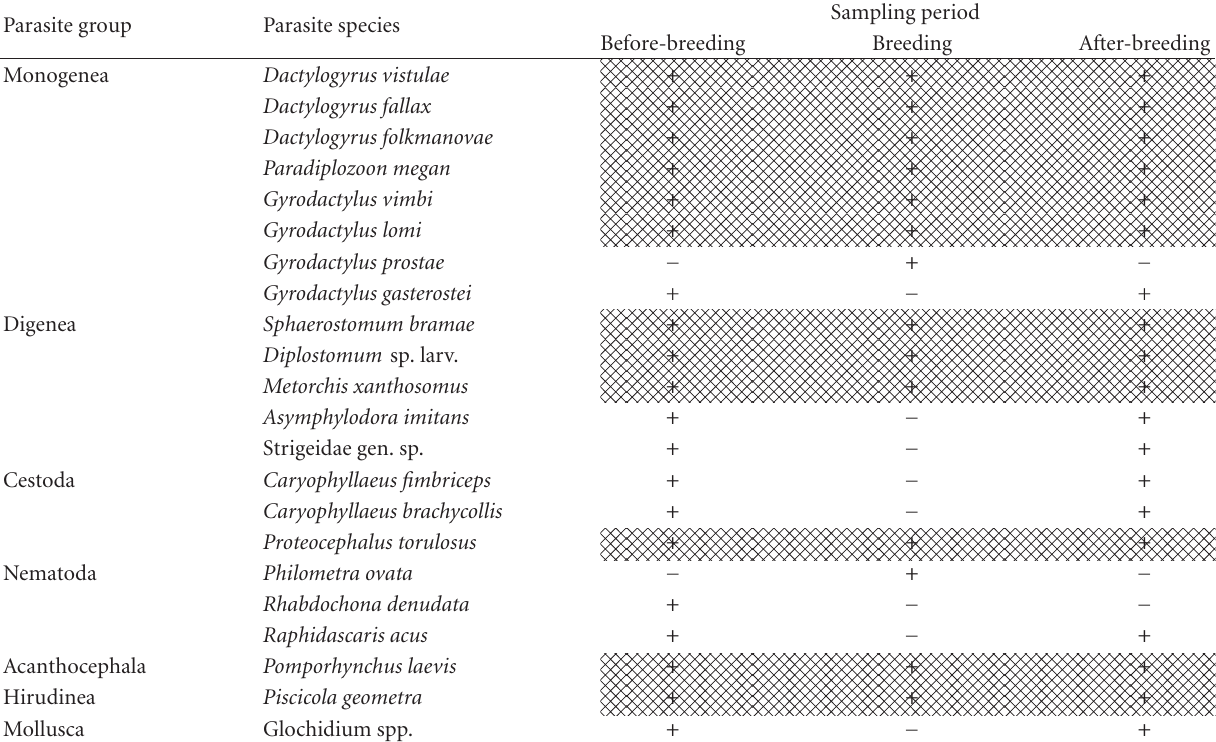
Table 2: Presence (+) and absence ( − ) of parasite species in each sampling period. Hatching areas indicate the presence of a given species in all three periods